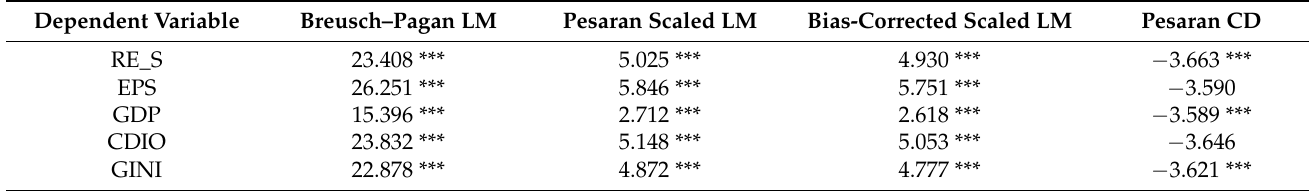
Table 4. Cross-sectional dependency test (CD) for model 2.